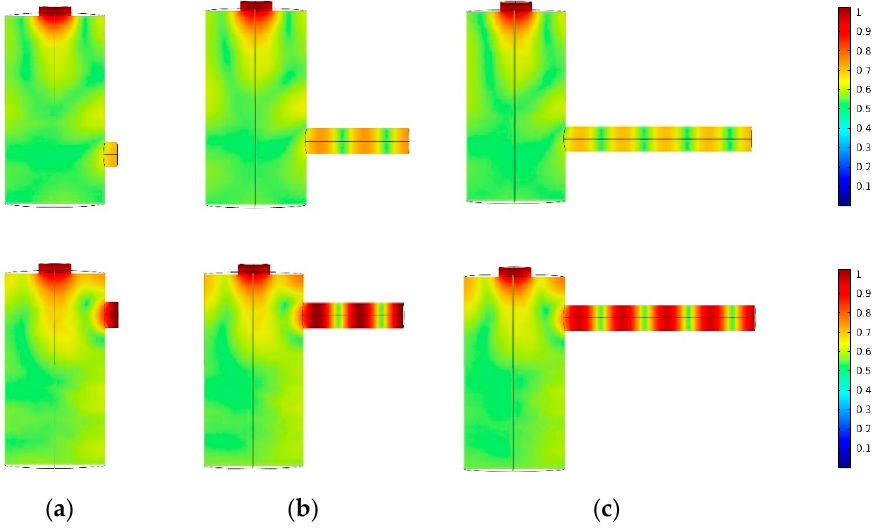
Figure 4. Relative photoacoustic (PA) signal of the coarse resonance cylinder sweep (a) along with a contour plot (b). The color scale gives the values of 𝜍 . The peak highlighted in the left plot is the region with the highest relative PA signal.